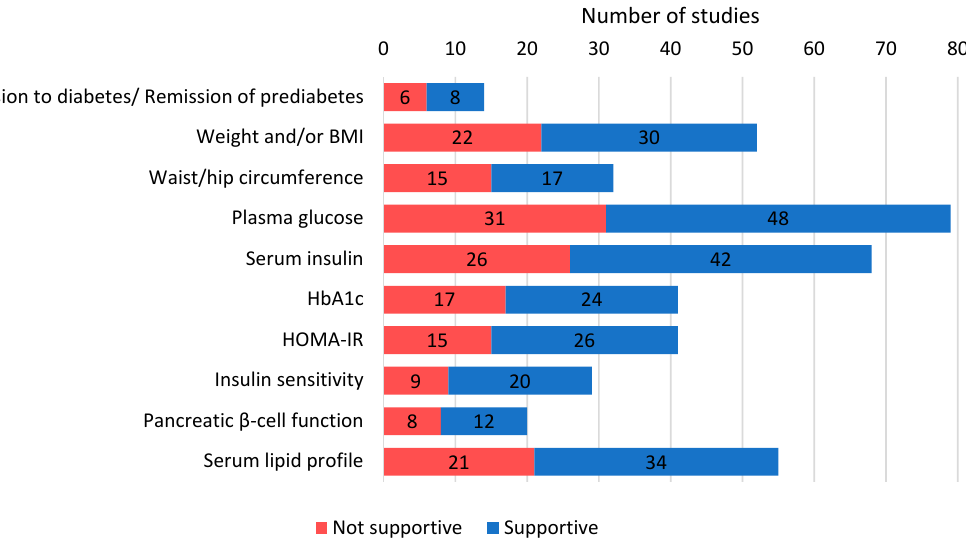
Figure 4. Bar graph showing number of studies reporting selected main outcomes and their proportions that demonstrated statistically significant improvements. Note: HbA1c, glycosylated hemoglobin; HOMA-IR, homeostatic model assessment of insulin resistance.